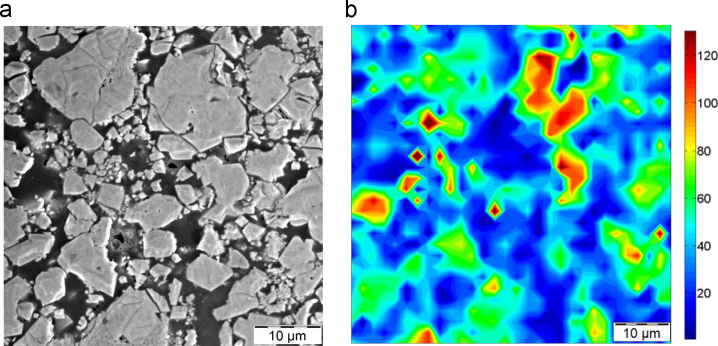
(a) SEM micrograph highlighting the nanoindentation area for LixMn2O4 cathode and (b) 2D nanoindentation modulus maps (units in GPa).